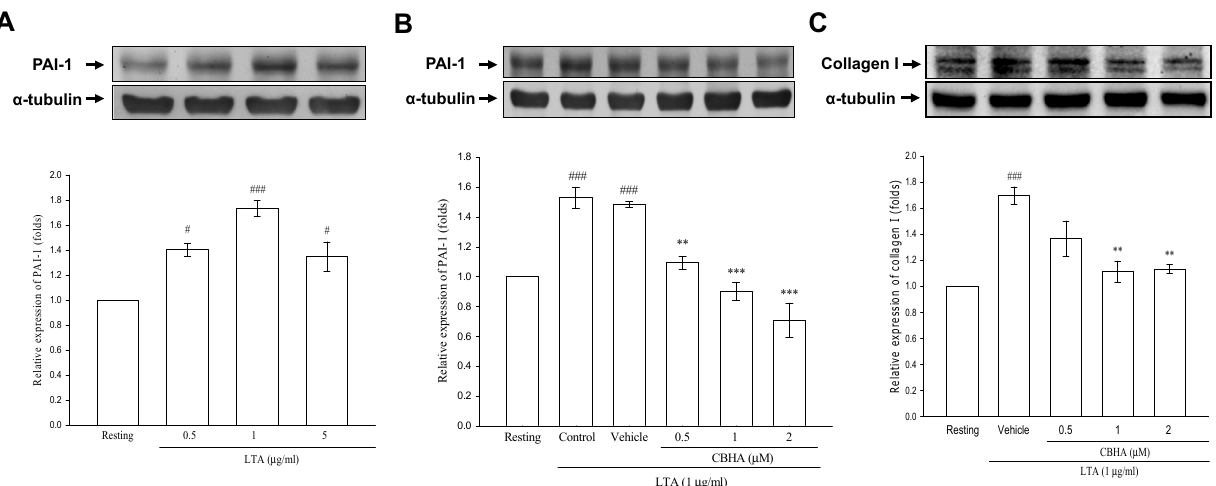
Figure 2. CBHA inhibits LTA-induced PAI-1 and collagen expression in human PMCs. ( A ) Primary pleural mesothelial cells were treated with LTA (0.5–5 μ g/mL) for 24 h, and PAI-1 expression was analyzed by western blot and measured by optical densitometry analysis. Data were pooled from four independent experiments and expressed as average fold change (mean ± SEM) in the expression relative to resting group. ( B , C ) MeT-5A cells pretreated with various concentrations of CBHA (0.5–2 μ M) or vehicle (Dimethyl sulfoxide; DMSO) was stimulated with LTA (1 μ g/mL) for 24 h. PAI-1 ( B ) or collagen-I ( C ) expression was analyzed by western blot and measured by optical densitometry analysis. Data were pooled from four independent experiments and expressed as average fold change (mean ± SEM) in the expression relative to resting or vehicle group. # p < 0.05 and ### p < 0.001 compared to the resting group. ** p < 0.01 and *** p < 0.001 compared to the vehicle (DMSO) group.